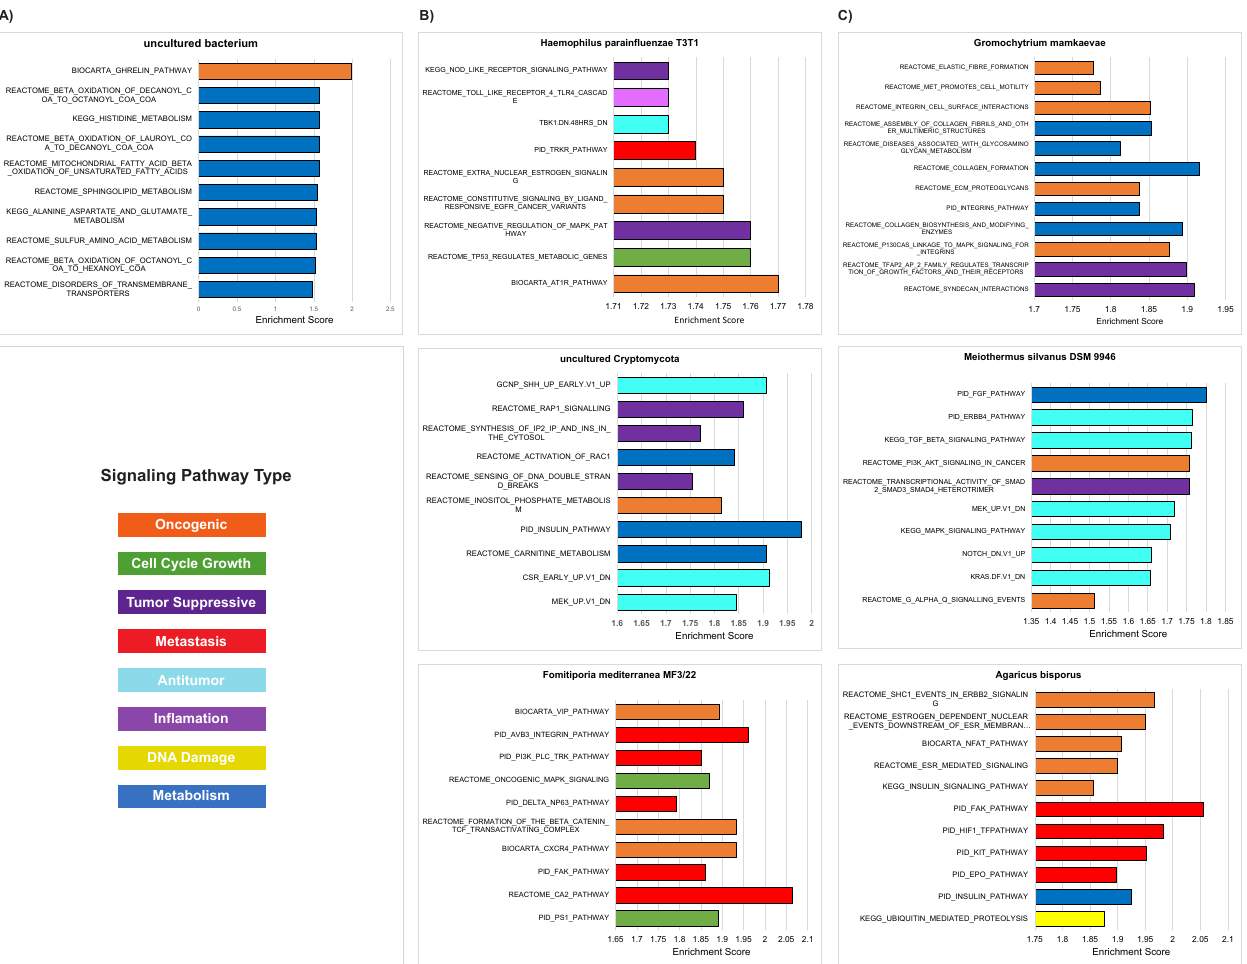
Figure 9. GSEA pathways for microbes from etiological cohorts. Specific GSEA pathways and signatures are provided for by selected microbes from each of the three main etiological cohorts: HPV-infection, smoking, and alcohol consumption. All selected pathways are statistically significant ( p < 0.05 and false discovery rate (FDR) < 0.25). For all bar graphs, the abundance of the microbes is correlated with the upregulation of the pathways presented. ( A ) Bar plot visualizing enriched pathways for uncultured bacterium , which is a dysregulated microbe in the HPV+ tumor samples. ( B ) Bar plots visualizing enriched pathways for microbes in the HPV- smoking and HPV- nonsmok- ing samples. Specifically, Haemophilus parainfluenzae T3T1 and Fomitiporia mediterranea MF3/22 are dysregulated microbes in the HPV- nonsmoking samples, while Agaricus bisporus is a dysregulated microbe in the HPV- smoking samples. ( C ) Bar plots visualizing enriched pathways for microbes in the heavy drinker and nondrinker cohorts. Gromochytrium mamkaevae is a dysregulated microbe specific to heavy drinkers, while Meiothermus silvanus DSM 9946 and uncultured Cryptomycota are dysregulated microbes specific to